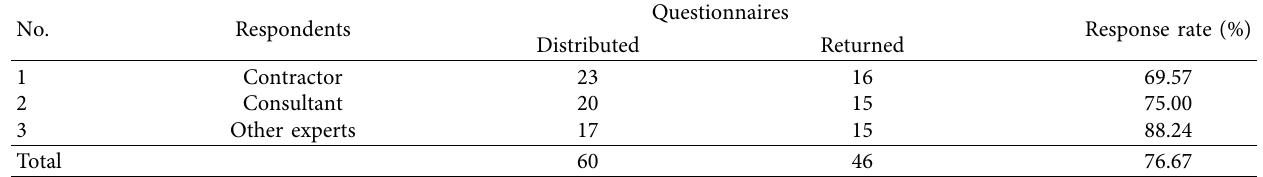
Table 3: Response rate of respondents.